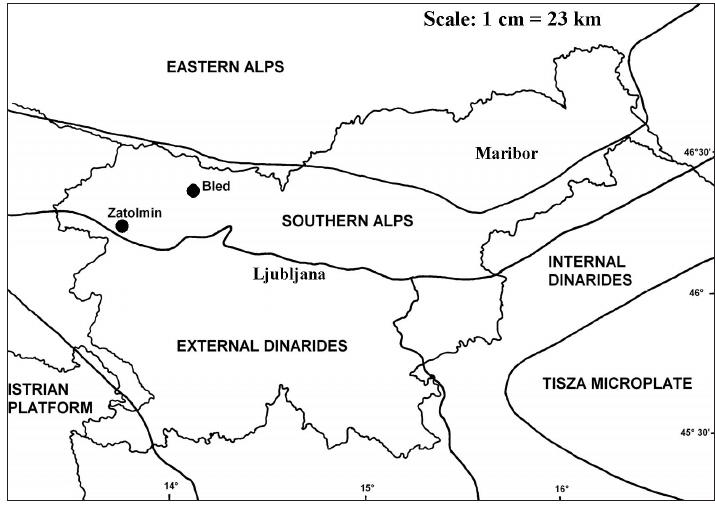
Fig. 1. Geotectonic situation of Slovenia and locations of the thermal springs at Zatolmin and